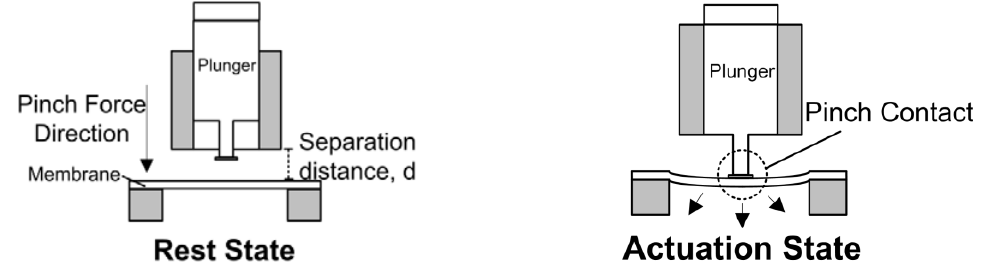
Figure 2. Schematic illustration of pinch actuation operation in rest and actuation mode.